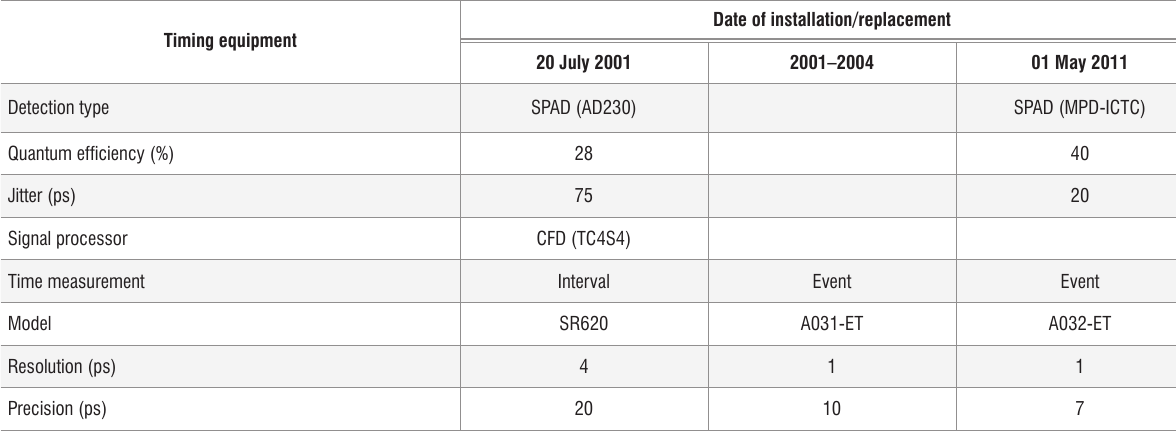
Timing equipment